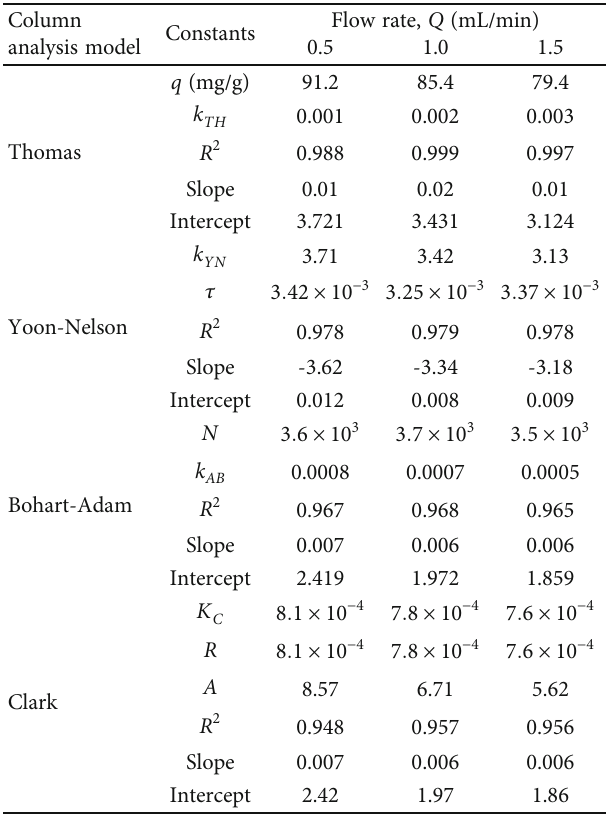
Table 11: Parameters for di ff erent column study models for di ff erent fl ow rates. Column analysis model